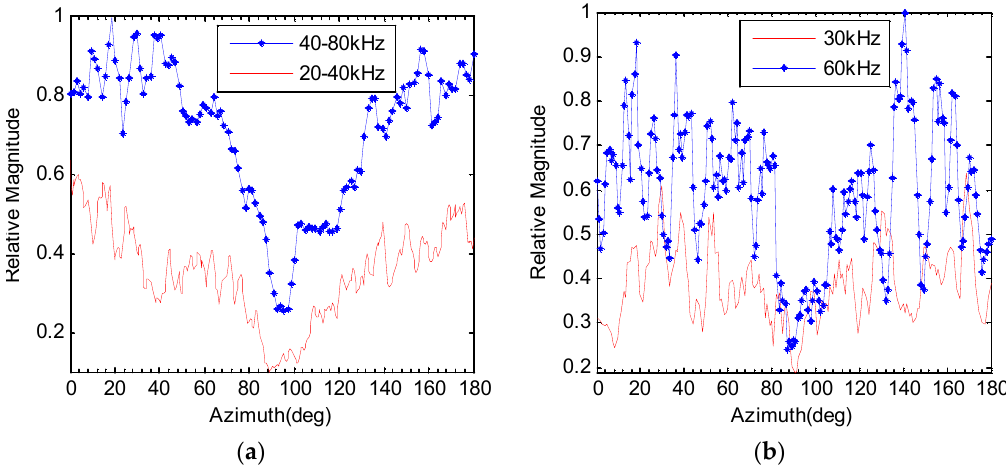
Figure 8. Theoretical and tested echo envelope fluctuation intensity with the frequency of LFM 20–40 kHz. ( a ) The pulse length is 1 ms; ( b ) the pulse length is 3 ms.